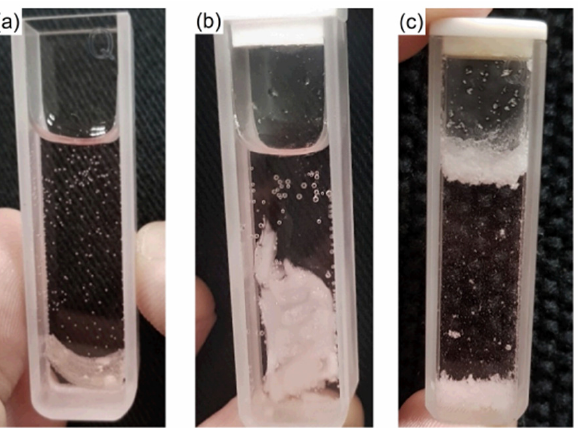
Figure 10. Korsmeyer–Peppas plot for the release at pH 7.